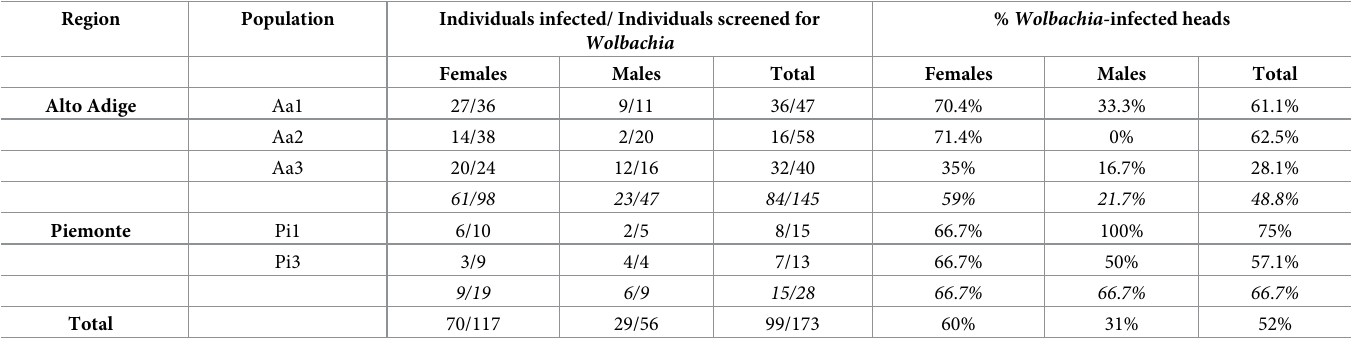
The Italian populations of P . spumarius screened for Wolbachia infection and with at least four individuals sequenced for the mitochondrial COI gene were considered for the analysis of molecular diversity. Overall, 27 populations and 226 individuals were analyzed (S1 Table). In detail, 16 populations were from three regions of northern Italy (Alto Adige, Piemonte and Table 2. PCR detection of Wolbachia in the head of infected individuals of Philaenus spumarius . Percentage of infected heads calculated on the number of infected individuals.